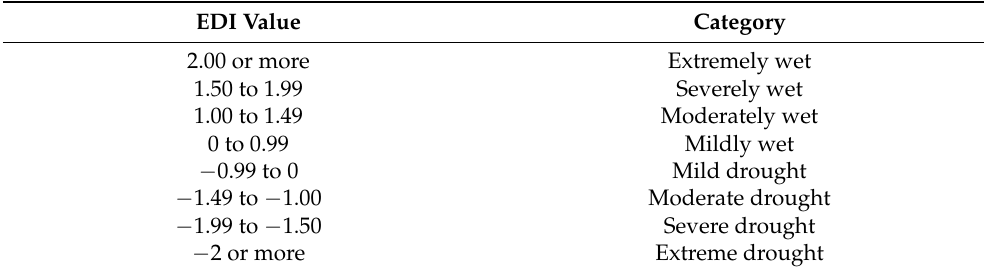
Table 4. Categories associated with EDI values